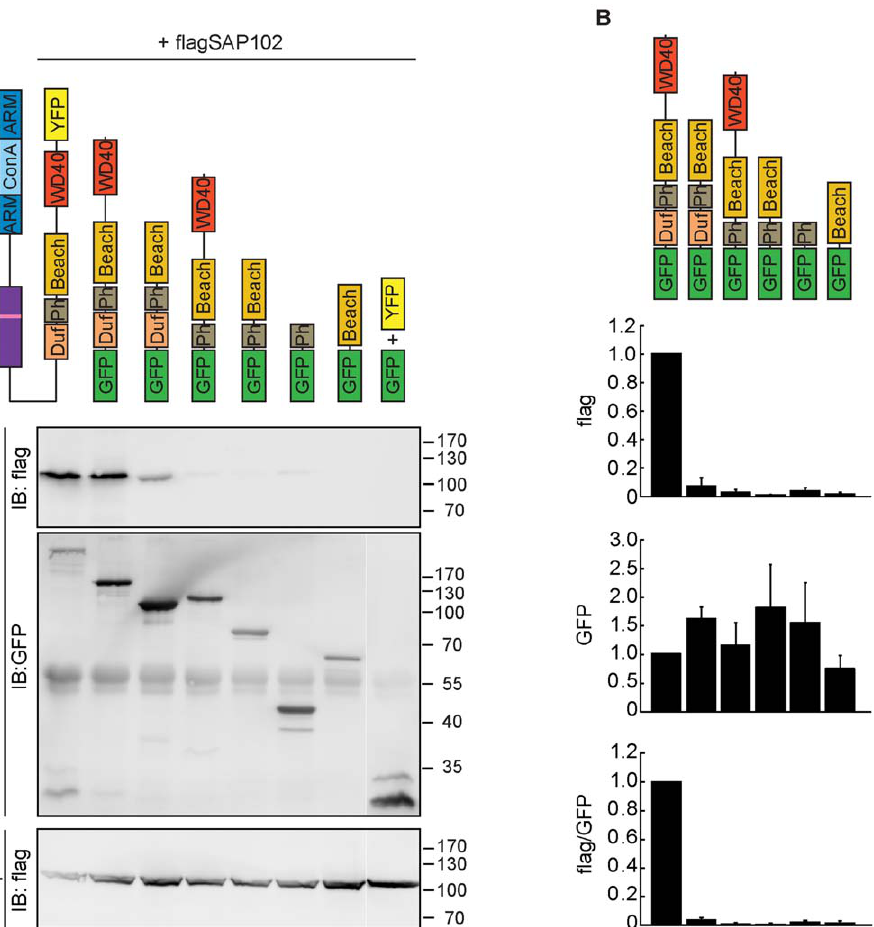
Figure 3. SAP102 binds to the C-terminal part of Nbea. (A) HEK293 cells were co-transfected with flag-tagged SAP102 and either full-length Nbea tagged with YFP or various Nbea deletions encompassing different domains fused to GFP. Following deletions were used: GFP-Duf, PH, BEACH, WD40; GFP-Duf, PH, BEACH; GFP-PH, BEACH, WD40; GFP-PH, BEACH; GFP-PH; GFP-BEACH. In the control condition SAP-102 was co-transfected with YFP and GFP. IPs were performed using the a -GFP antibody, before immune-blotting with a -flag and a -GFP antibodies. (B) Quantification of flag and GFP protein levels using the immuno-labelled bands. Error bars indicate the standard error of the mean (SEM).